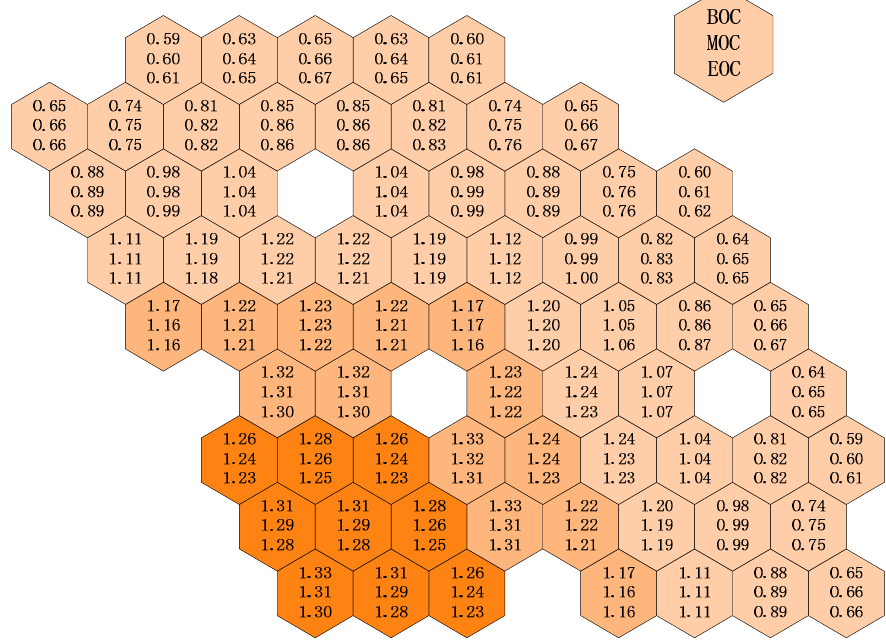
Figure 6. Comparison of power peaking factors at BOC, MOC and EOC for ARO core.